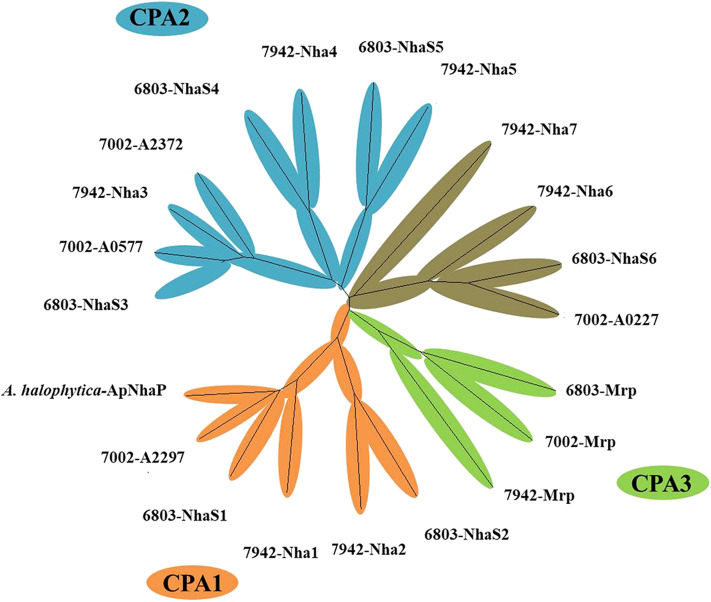
Neighbor-joining phylogenetic tree of transporter proteins from high, moderate, and poor salt tolerant cyanobacteria.